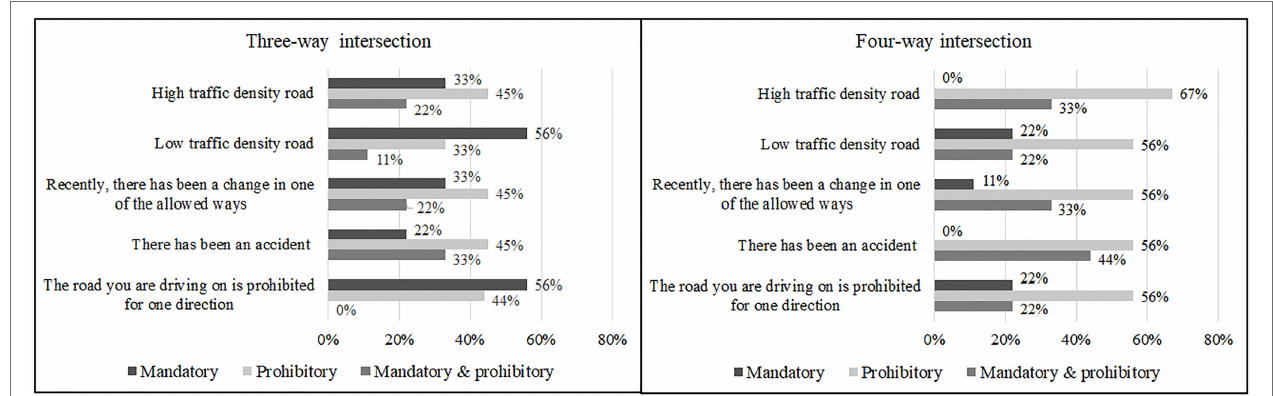
FIGURE 4 | Percentage of choices of signs used most frequently to signpost at three and four-way intersections in different